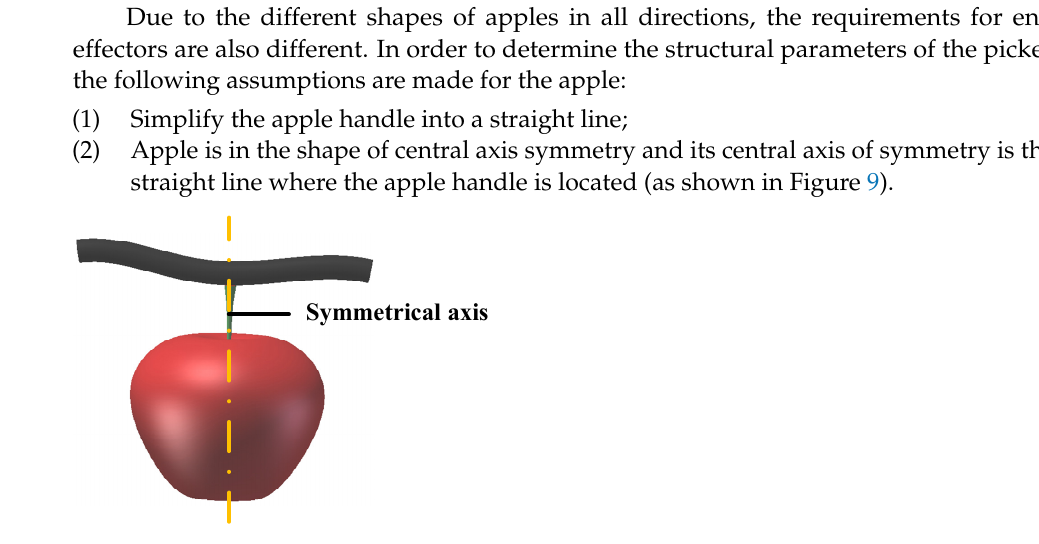
Figure 11. Apple shoulder and bottom schematic. Given the curvature formula in two dimensions, its scalar form is: 2